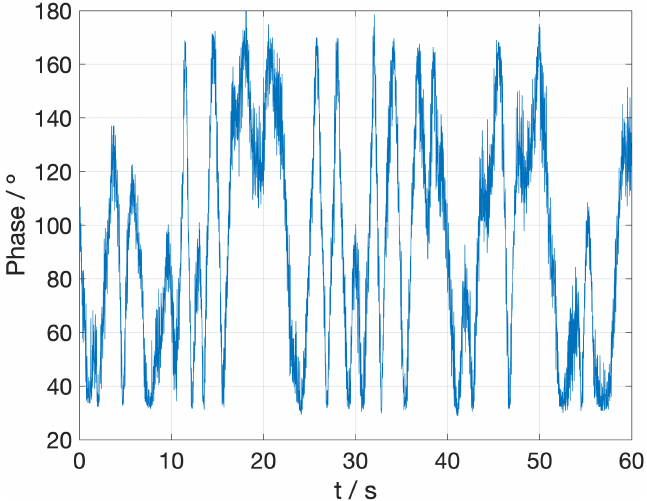
Figure 7. Phase noise extracted from the signal measured by the demonstrator. Time intervals have been modified to make simulation